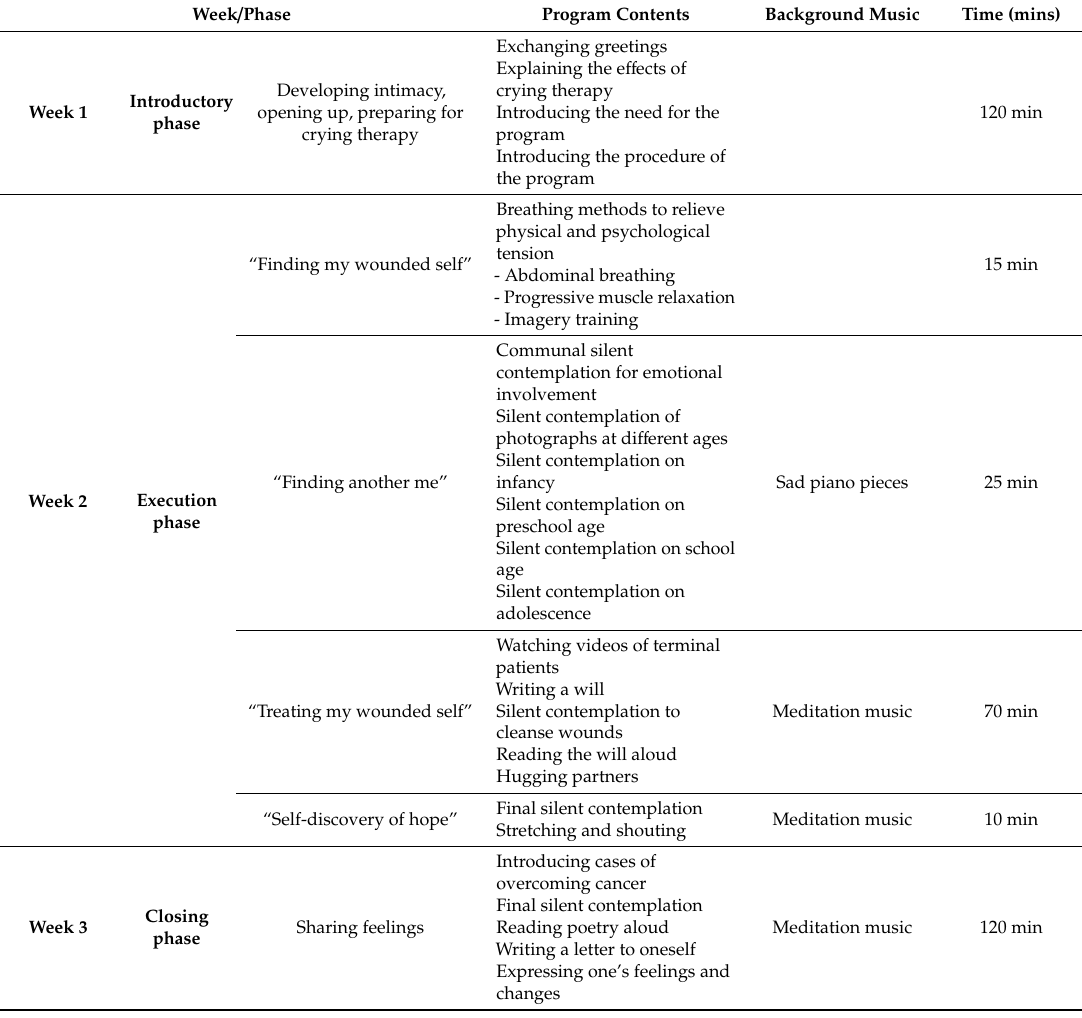
Table 1. Development of crying therapy